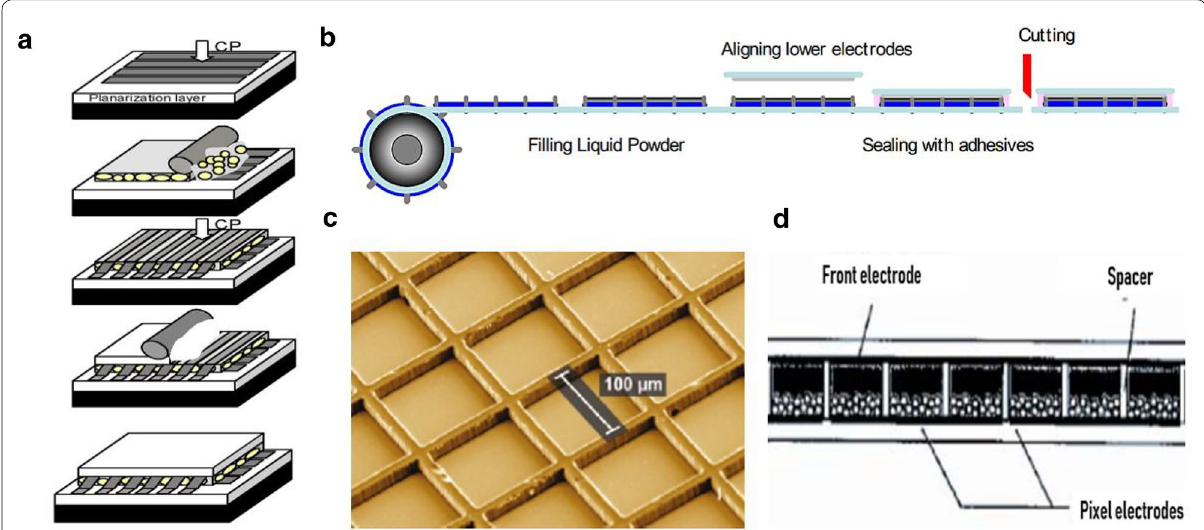
Fig. 15 Display fabrication processes and pixel structures. a Schematic process of layer‑to‑layer fabrication of the reflective display, reproduced with permission. b Roll‑to‑roll process for liquid powder display fabrication. c ITO grid patterned by lithography. d Structure of electrophoretic display with spacers (Figure reproduced from a [99], Copyright 2006, Society for Information Display; b [18], Copyright 2006, Society for Information Display; c [101], Copyright 2010, American Chemical Society; d [101], Copyright 2005, John Wiley & Sons,